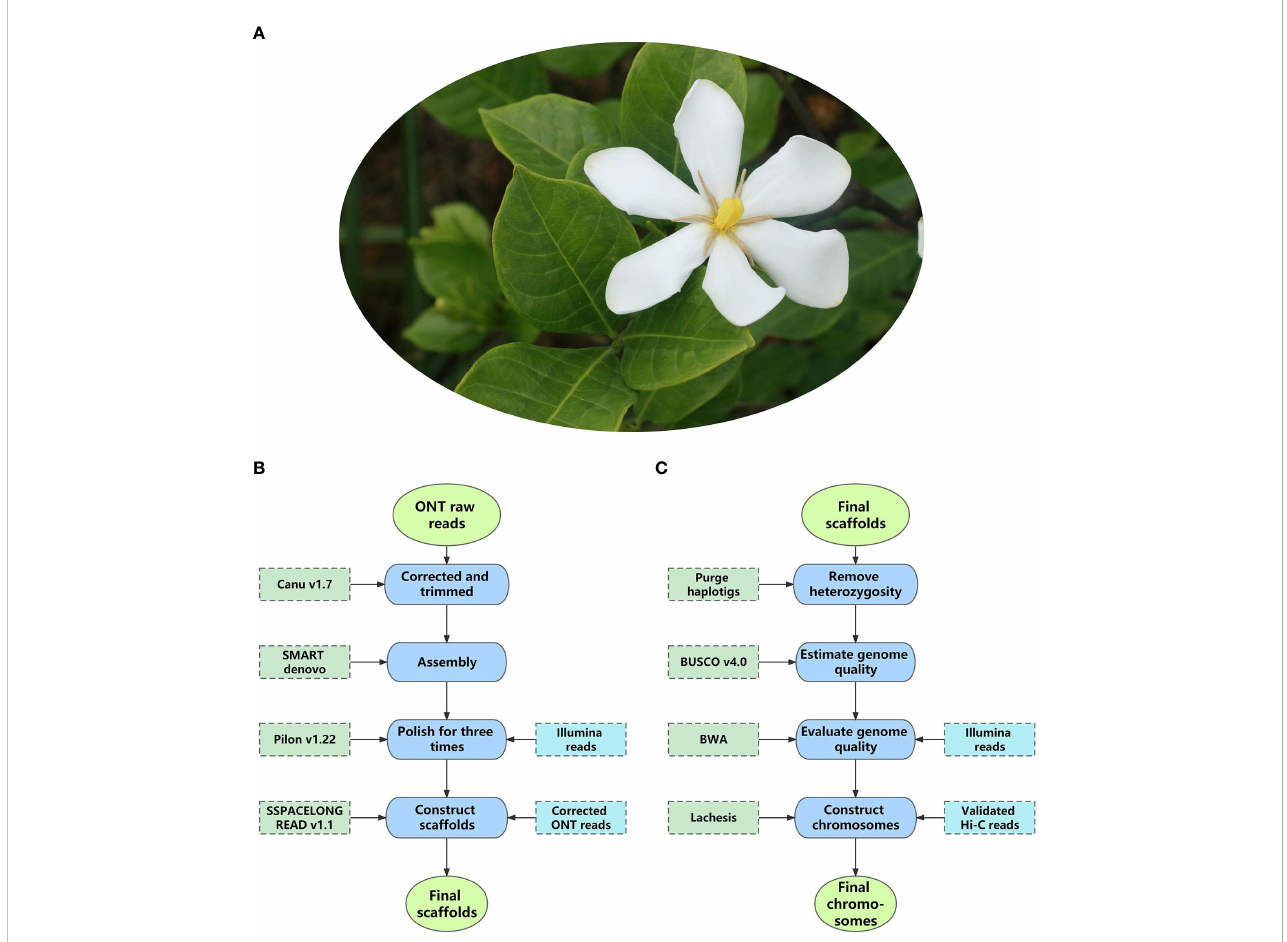
FIGURE 3 The pipeline of chromosome-level assembly of Gardenia jasminoides genome. (A) The fl ower of Gardenia jasminoides . (B) The pipeline for assembling the raw data into scaffolds. (C) The pipeline for assembling scaffolds into